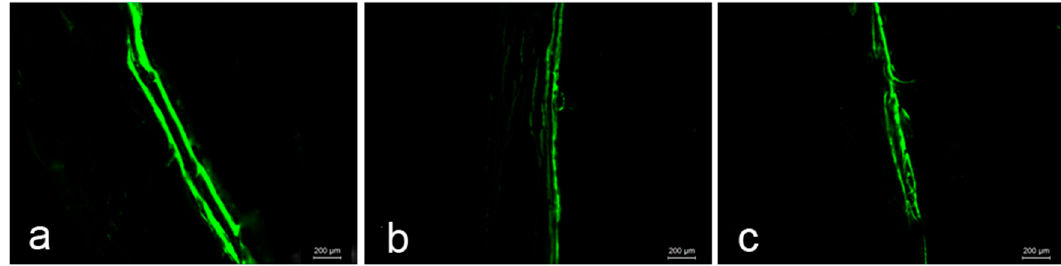
Figure 3. Representative fluorescence micrographs of trabecular bone sections showing green calcein labels within various treatment groups: ( a ) control; ( b ) HLU and ( c ) HLU–DRTF.